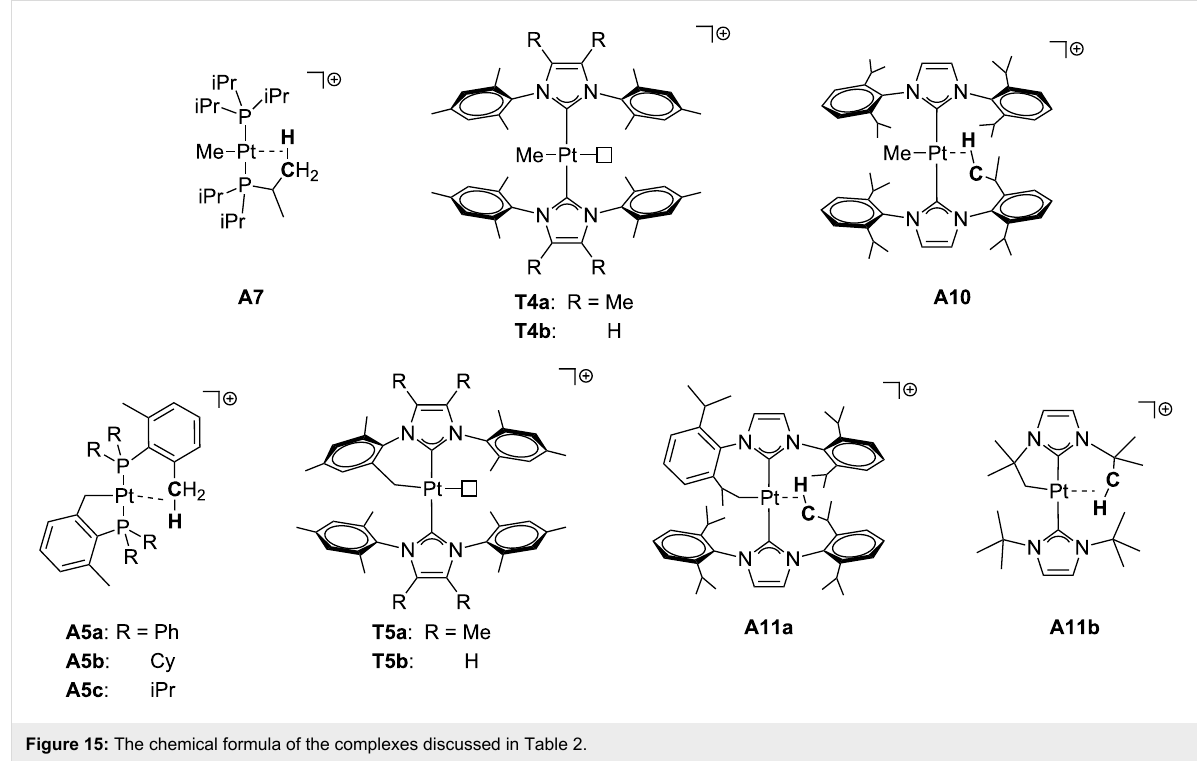
Figure 15: The chemical formula of the complexes discussed in Table 2.